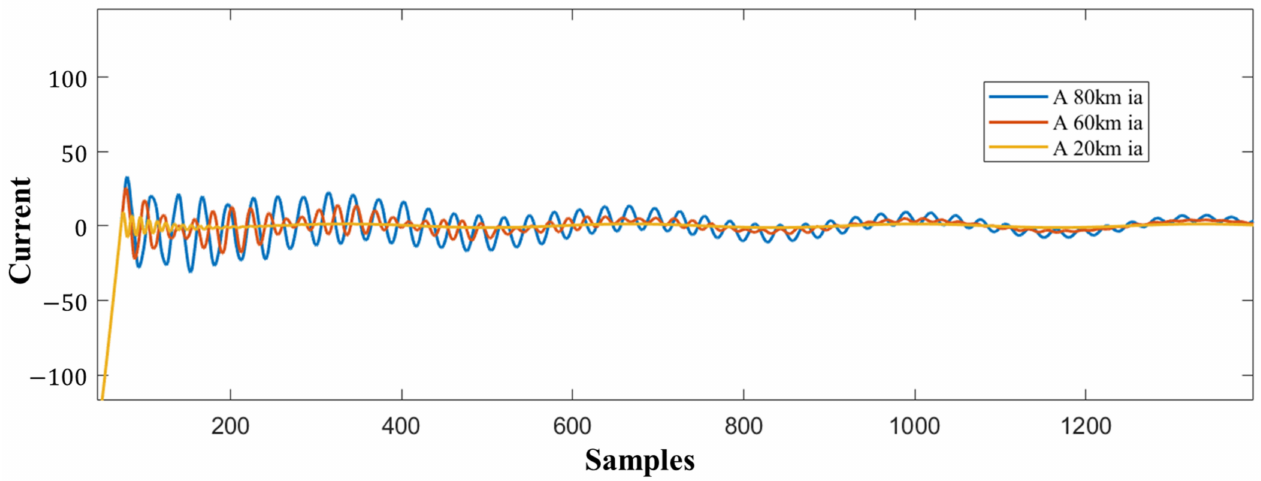
Figure 7. Fault current of phase A by